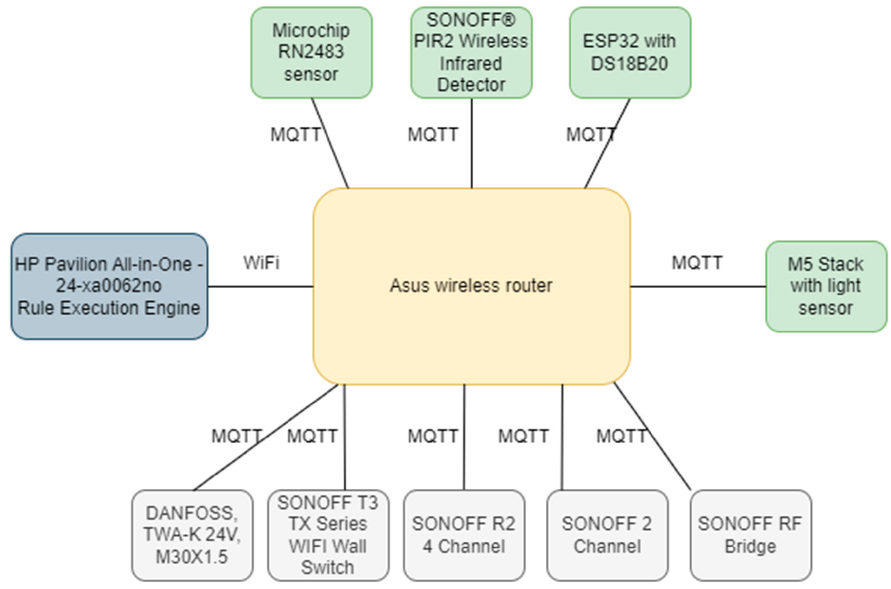
Figure 3. Communication of hardware agents.